Question: In a single sentence, describe what this figure presents.
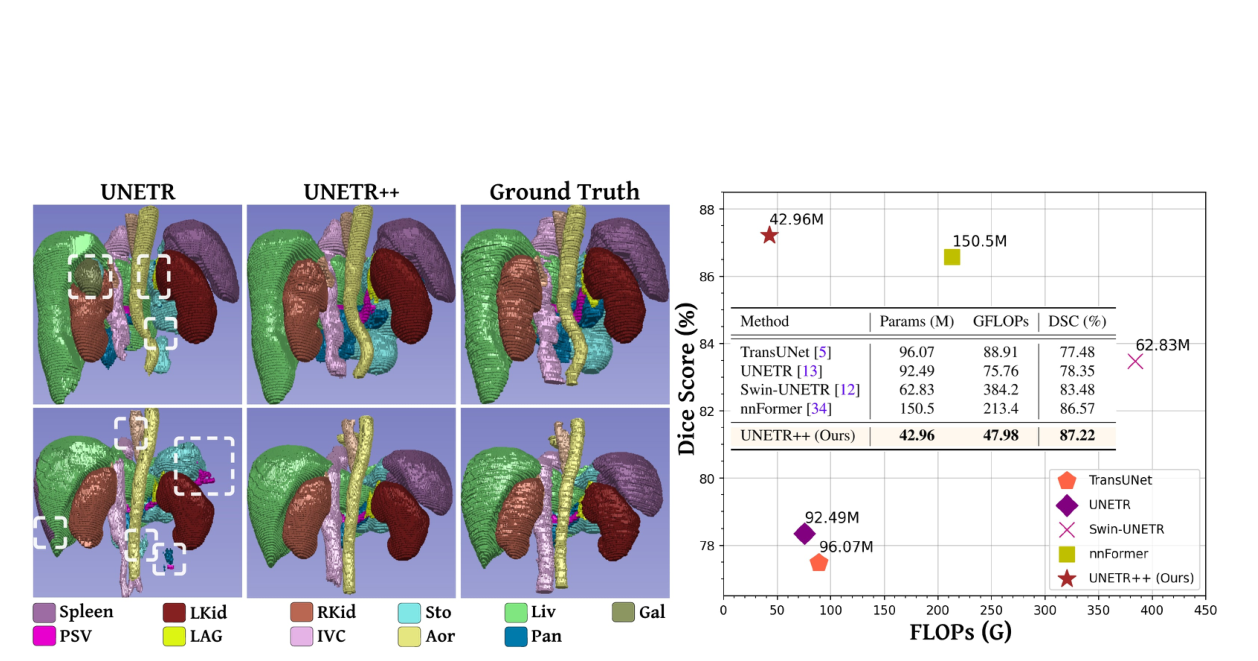
Answer: Left: Qualitative comparison between the baseline UNETR [13] and our UNETR++ on Synapse. We present two examples containing multiple organs. Each inaccurate segmented region is marked with a white dashed box. In the first row, UNETR struggles to accurately segment the right kidney (RKid) and confuses it with gallbladder (Gal). Further, both the stomach (Sto) and left adrenal gland (LAG) tissues are inaccurately segmented. In the second row, UNETR struggles to segment the whole spleen and mixes it with stomach (Sto) and portal and splenic veins (PSV). Moreover, it under and over-segments certain organs (e.g., PSV and Sto). In comparison, our UNETR++ that efficiently encodes enriched inter-dependent spatial and channel features within the proposed EPA block, accurately seg- ments all organs in these examples. Best viewed zoomed in. Additional qualitative comparisons are presented in Fig. 4 and supplementary material. Right: Accuracy (Dice score) vs. model complexity (FLOPs and